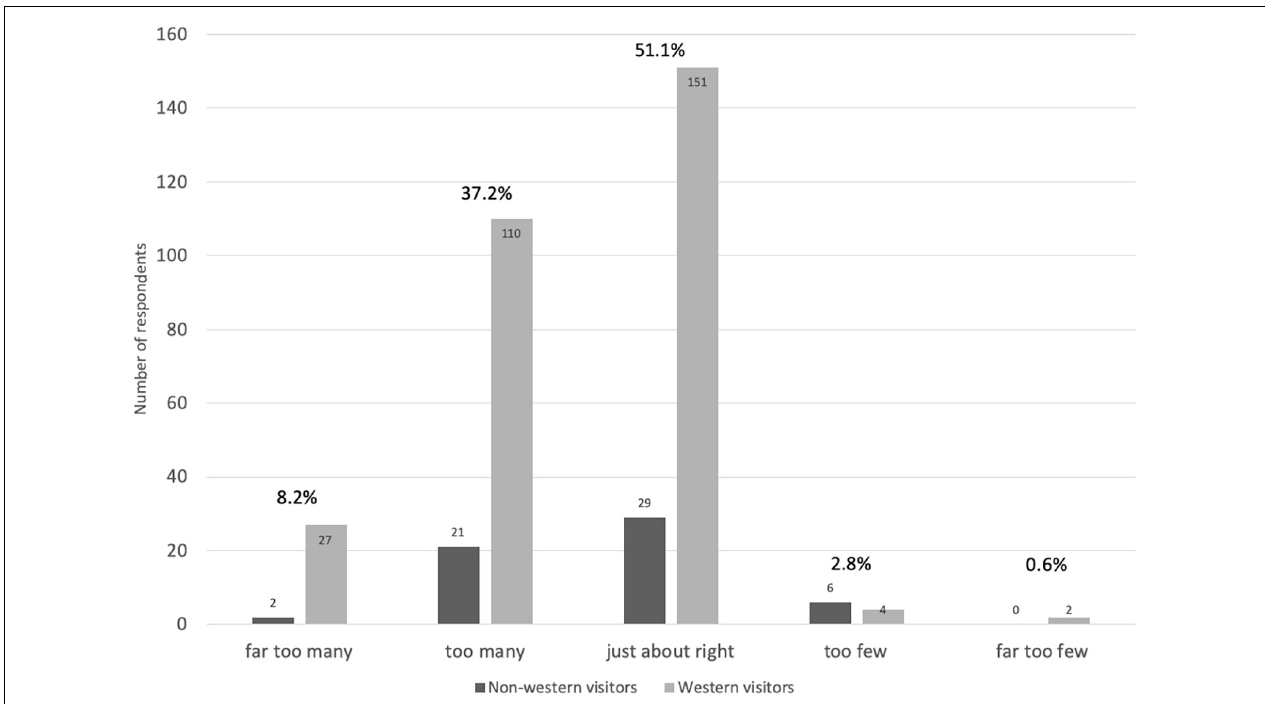
FIGURE 5 | The perception of crowding amongst tourist respondents ( n = 352) based on answered to the question “ You considered the number of boats around you to be ... ” (Pearson chi square p = 0.003 between Westerners and Non-Westerners). Percentage covers both Westerners and